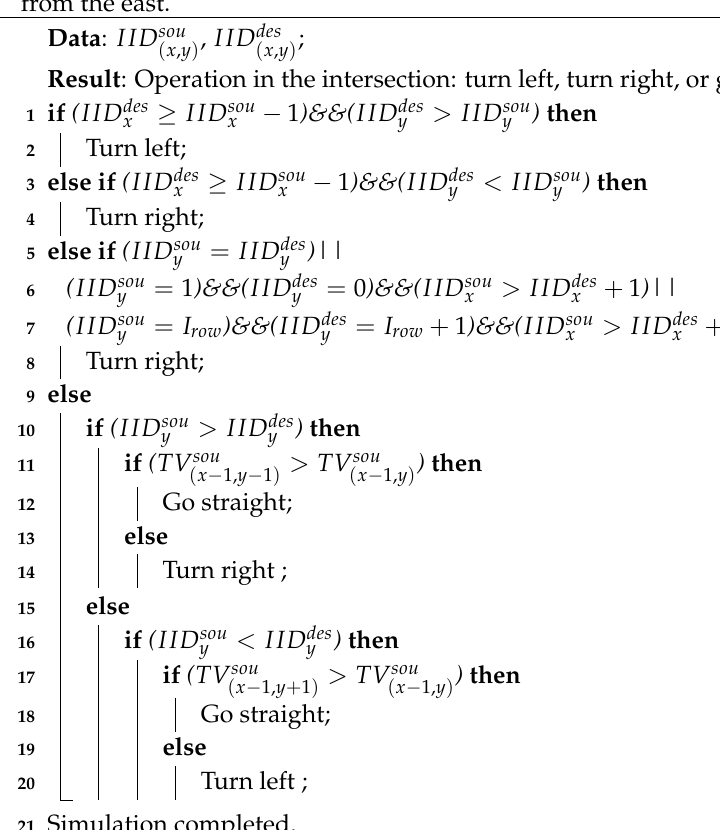
Algorithm 1: The algorithm for choosing the itinerary for each vehicle to enter the intersections from the